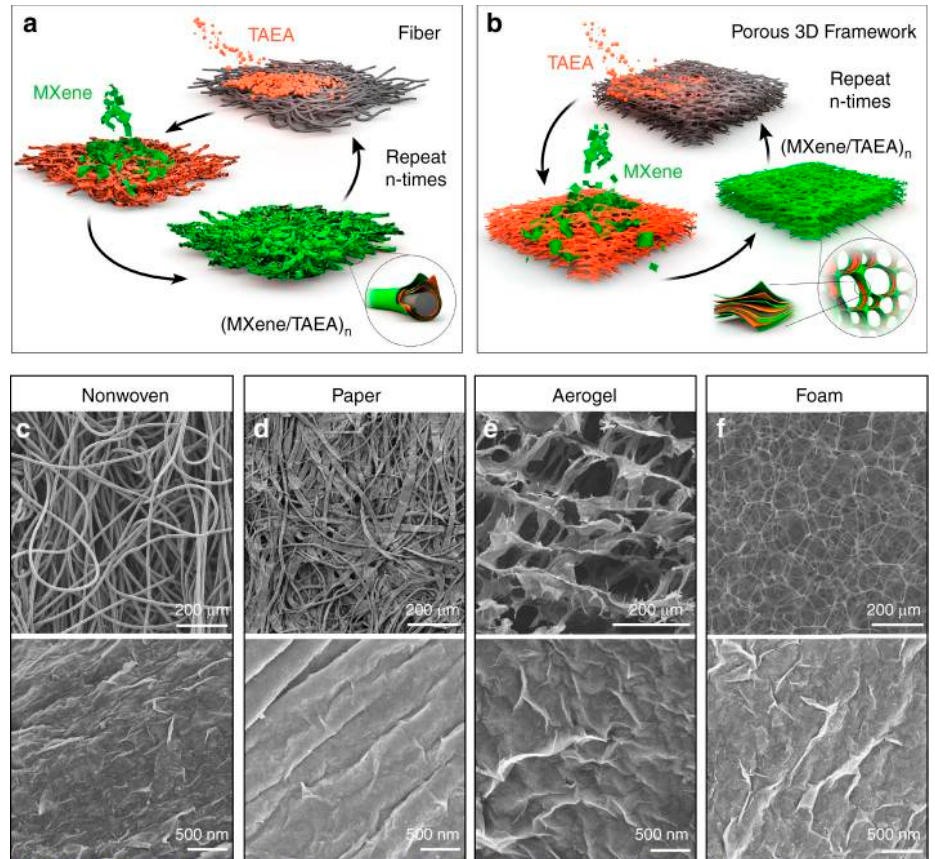
Figure 7. Sketch of the assembly process of LbL multilayers obtained by alternate deposition of MXene and tris(2-aminoethyl) amine for fiber ( a ) and 3D porous structures ( b ), and a set of images at two different magnifications of the LbL structures on different templates: Non-woven template ( c ), paper ( d ), aerogel ( e ) and foam ( f ). Reprinted from Tian et al. [133], with permission under Open access CC BY 4.0 license, https://creativecommons.org/licenses/by/4.0/ (accessed on 14 April 2022).